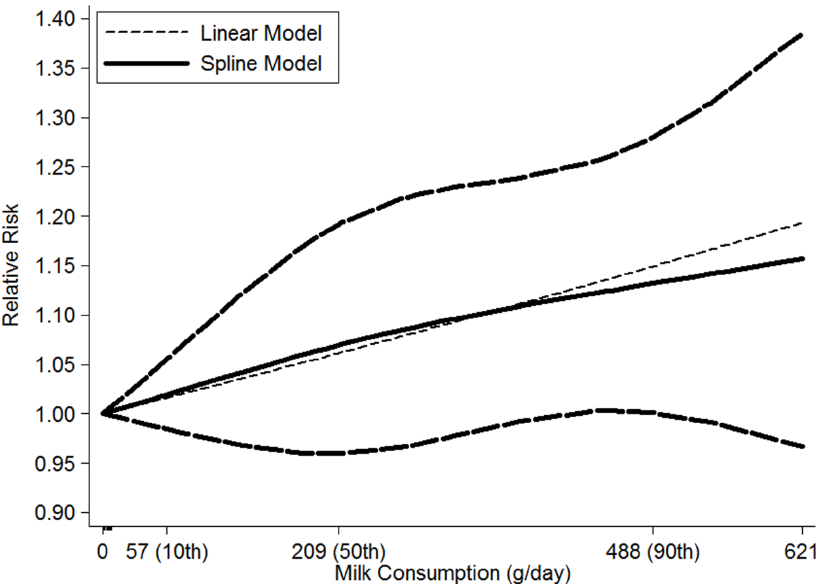
Figure 5. The dose-response analysis between milk consumption and the risk of NHL with restricted cubic splines in a multivariate random-effects dose-response model. The solid line and the long dash line represent the estimated relative risks and its 95% CIs. Short dash line represents the linear relationship. The 10th, 50th and 90th percentiles represent three knots of milk consumption.